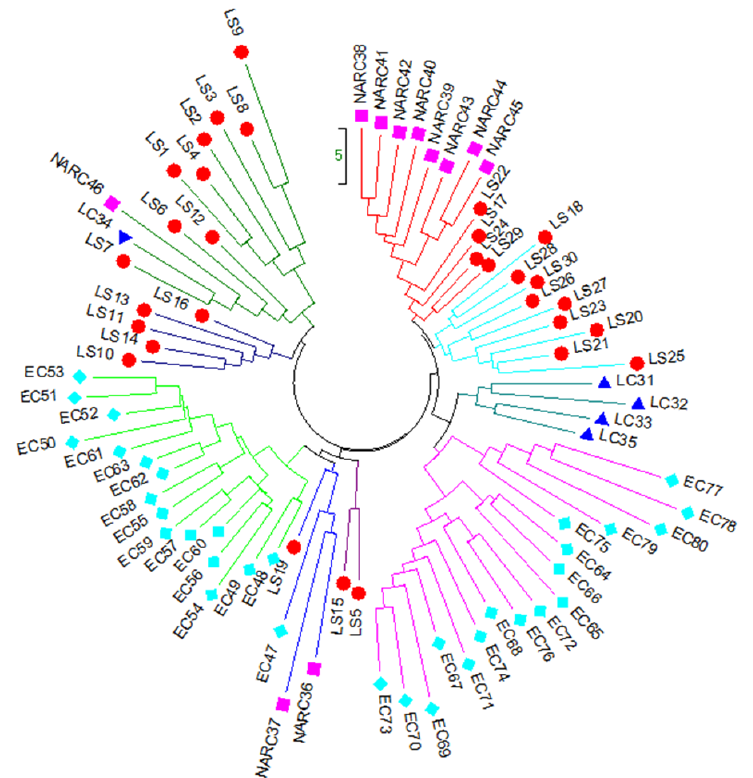
Figure 3. Neighbor-joining tree of 80 genotypes of potato generated with data from 11 iPBS primers showing 5 main clusters with some clusters containing sub-groups. Abbreviations are as follows: LS ( ), local strains; LC ( ), local cultivars; NARC ( ), and EC ( ), exotic cultivars.